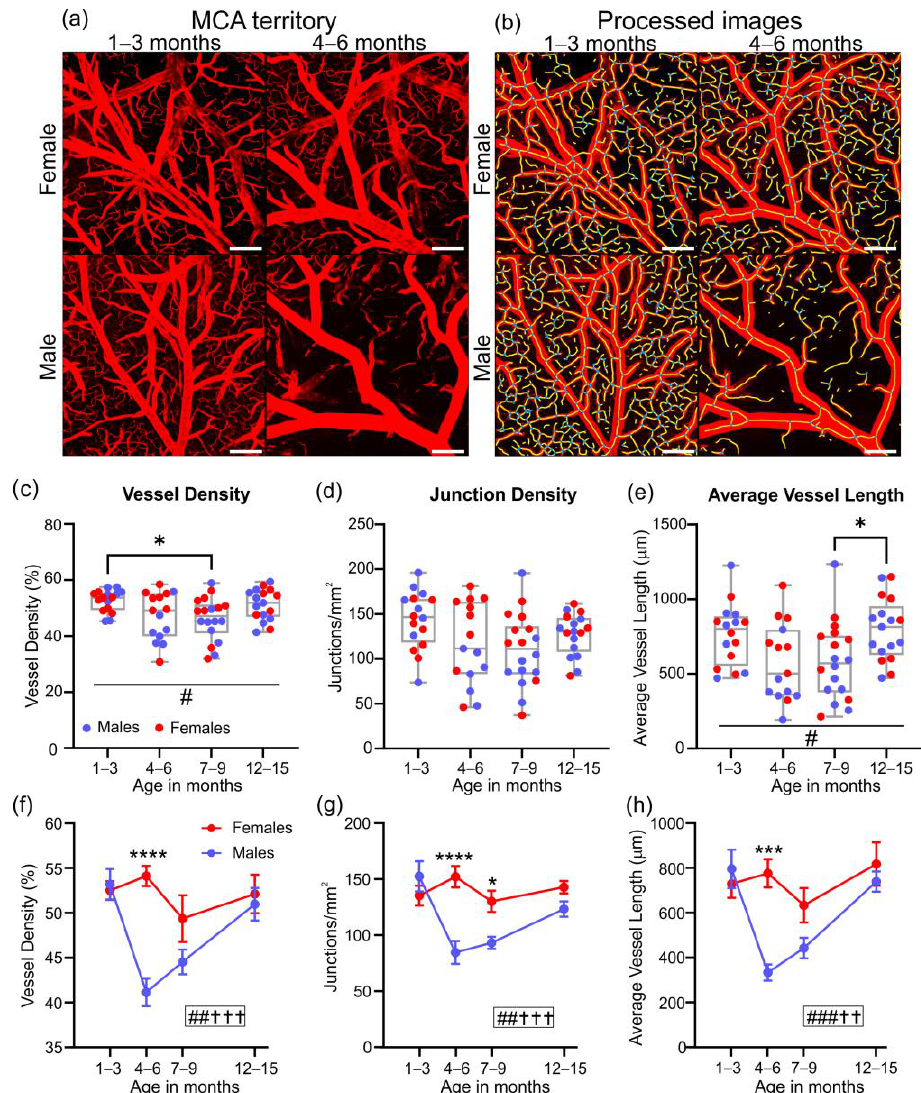
Figure 6. Assessment of the middle cerebral artery (MCA) territory vascular network. Representative MCA confocal images from vessel painted male and female mice at 1 – 3 and 4 – 6 months of age ( a ) and after Angiotool processing ( b ), where vessels are in yellow and junctions/branching points are in blue. Scale bars = 200 µm. 3xTg-AD MCA vessel characteristics, including vessel density ( c ), junction density ( d ), and average vessel length ( e ) reveal modest differences with age in vessel density and average vessel length. Male and female MCA vessel differences are shown for vessel density ( f ), junction density ( g ), and average vessel length ( h ), where the 4–6 month timepoint appears as a particularly vulnerable period in male mice. * p < 0.05, *** p < 0.001, **** p < 0.0001. # shows a significant effect of age, with # p < 0.05, ## p < 0.01, ### p < 0.001; † shows a significant effect of sex, with †† p < 0.01, ††† p < 0.001. Data shown in ( f – h ) as mean ±